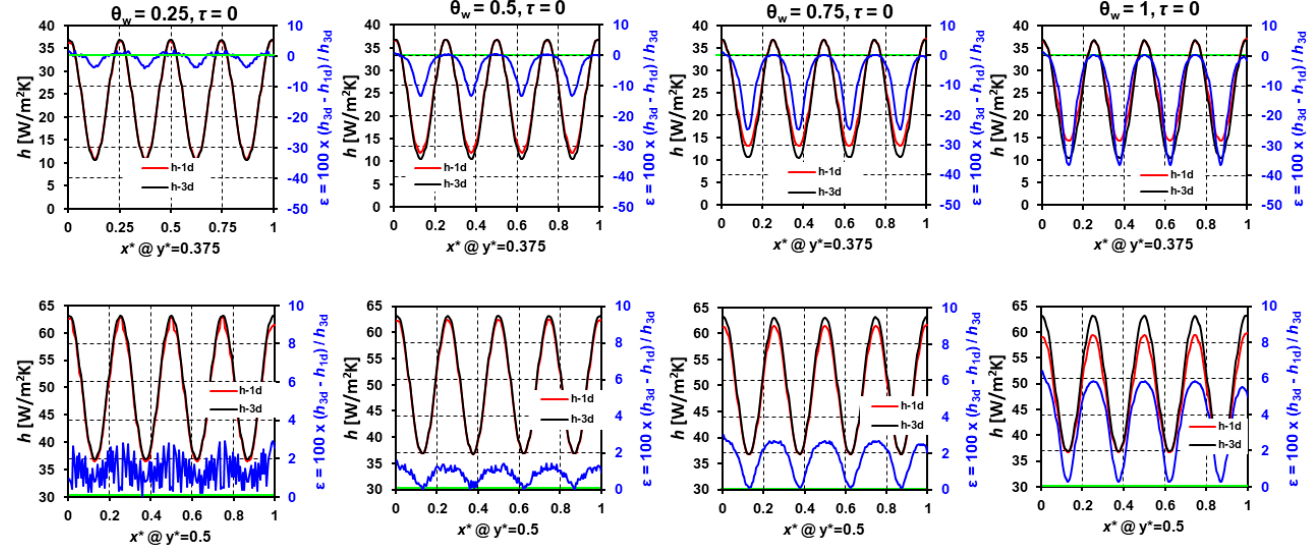
Figure 13. Method C, Case II: Local h variation at y* = 0.375 and y* = 0.5 and their relative % differ ‐ ences.